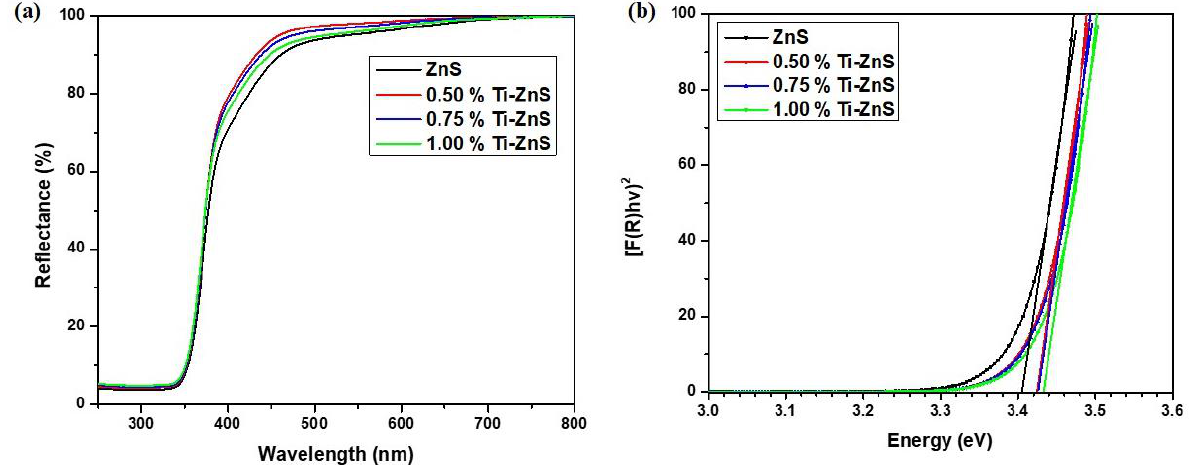
Figure 5. ( a ) UV-Vis spectra, ( b ) plot of [F(R) hν] 2 vs hν of undoped ZnS and Ti-doped ZnS nanopowder samples at different concentrations.